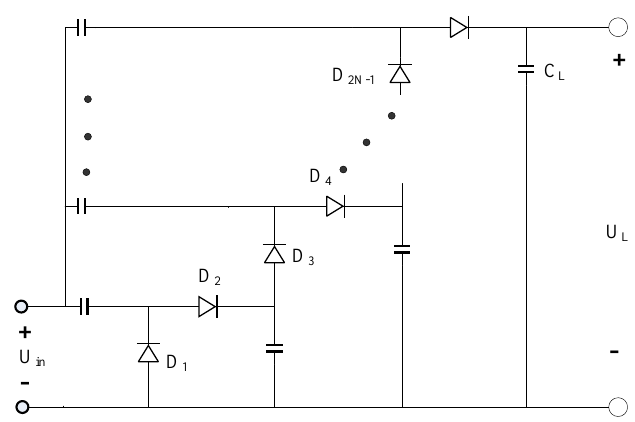
Figure 1. N-stage charge pump voltage rectifier.